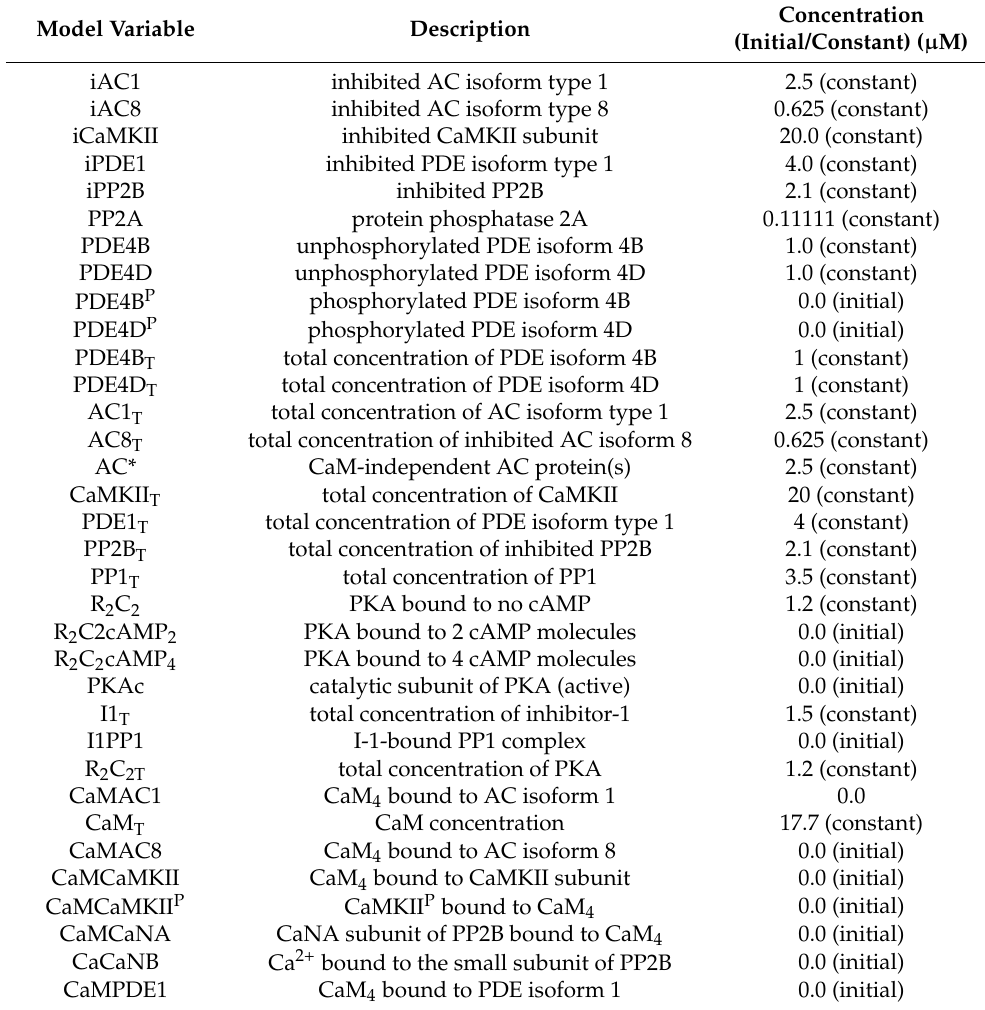
Table 2. Variables in the model. The variables treated as constant and initial values are indicated. All variables are taken from Tables 1 and 3 in [48].